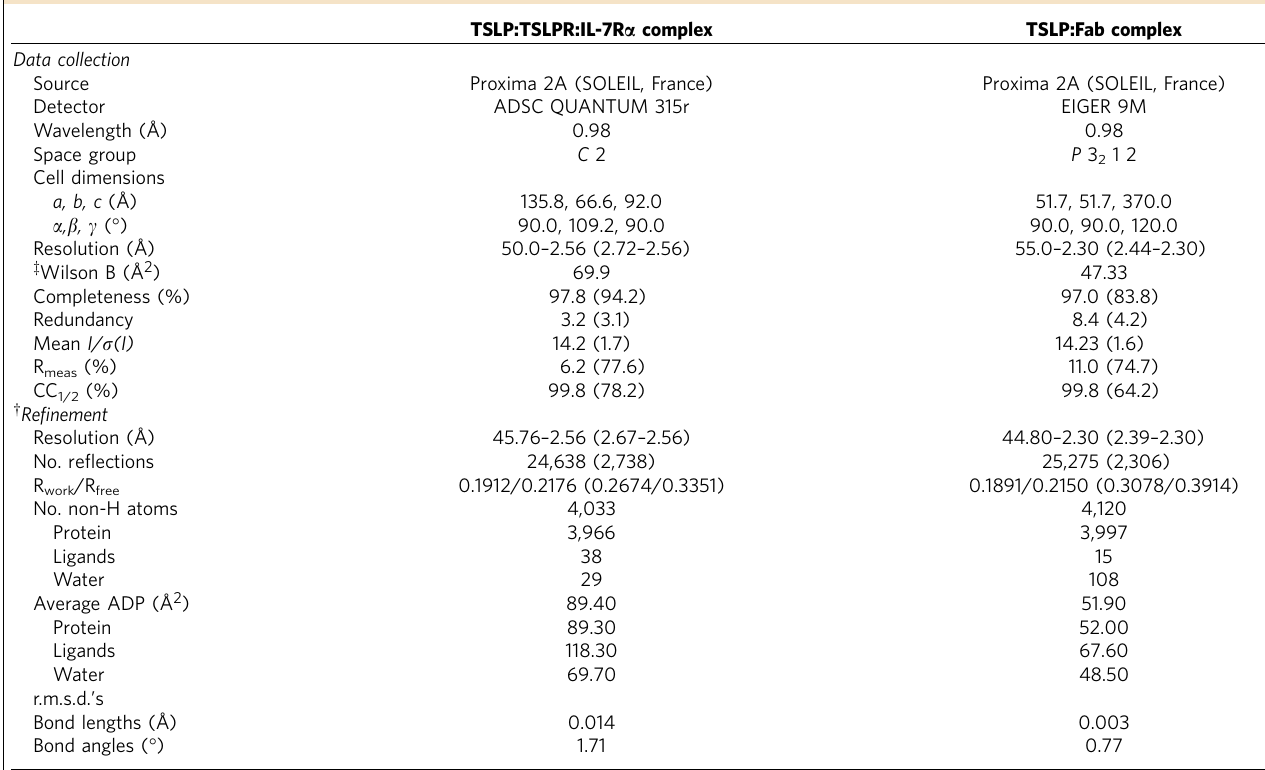
Table 1 | X-ray data set and refinement statistics* , w